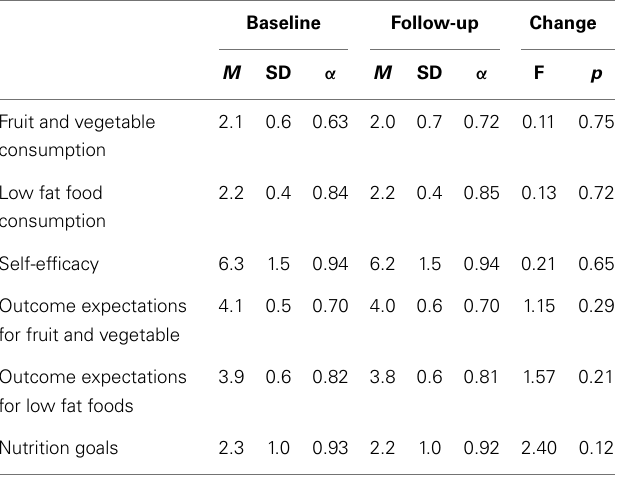
Table 1 | Descriptive statistics for social cognitive and nutrition outcome variables ( n = 179) .